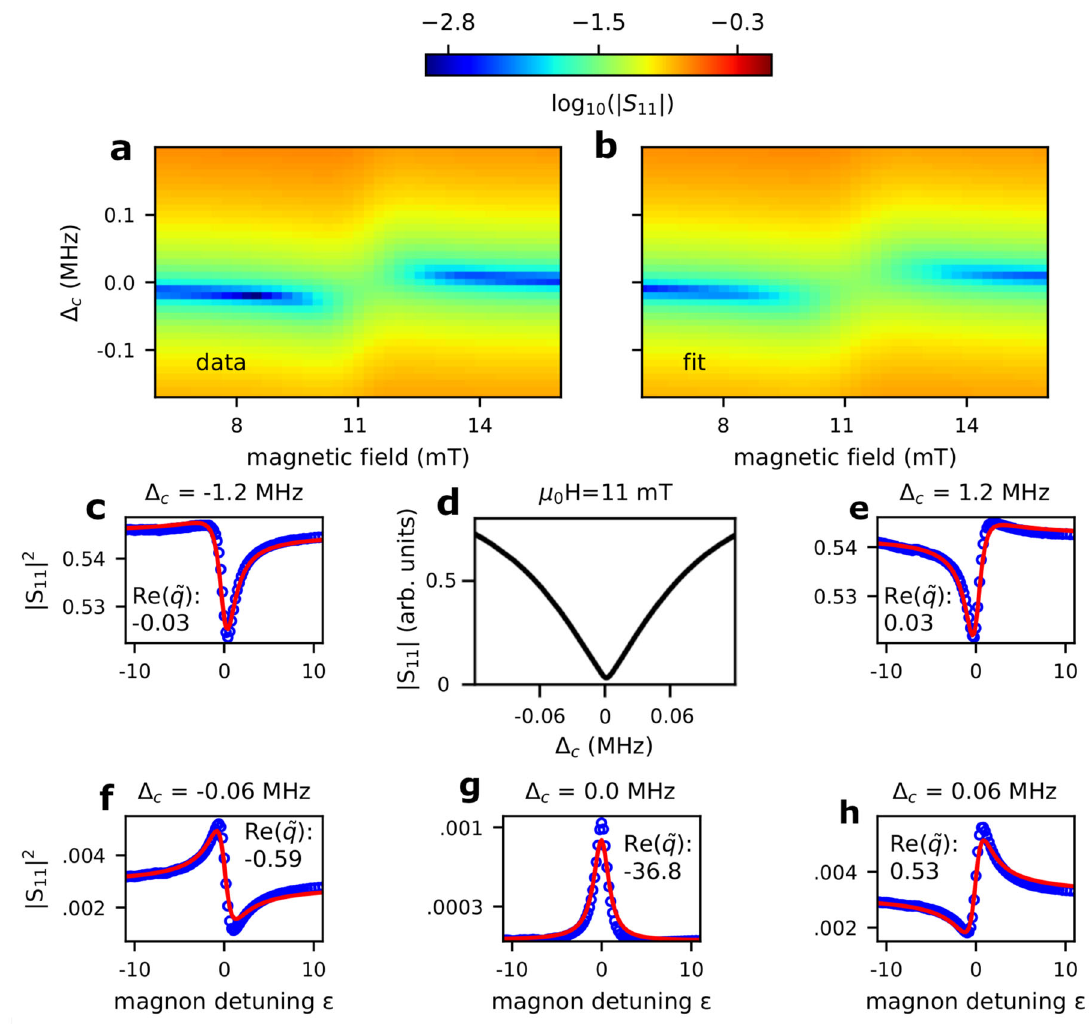
Fig. 1 Cavity re fl ectivity of the interaction between the microwave cavity mode and the magnon mode. a Magnitude of the measured re fl ectivity showing the Purcell effect for a thin 10 nm thick permalloy fi lm inserted into the cavity. The Kittel mode of the permalloy fi lm couples to the cavity photon, which is manifested as a distortion in the cavity resonance. A fi t of the re fl ectivity via Eq. (5) is shown in ( b ). The physical quantities extracted from the fi t and fi ts of the re fl ectivity performed for permalloy thicknesses of 40 nm and 200 nm are given in the Supplementary Table 1. d The fi xed fi eld lineshape at the resonant fi eld of the Kittel mode. Fixed frequency lineshapes as a function of the dimensionless magnon detuning for various cavity detunings are shown as open blue circles in ( c , e – h ). The fi ts of the lineshapes are performed in accordance with Eq. (6) as discussed in the text and are featured as red lines. The corresponding Re ~ q ð Þ value is shown next to each fi